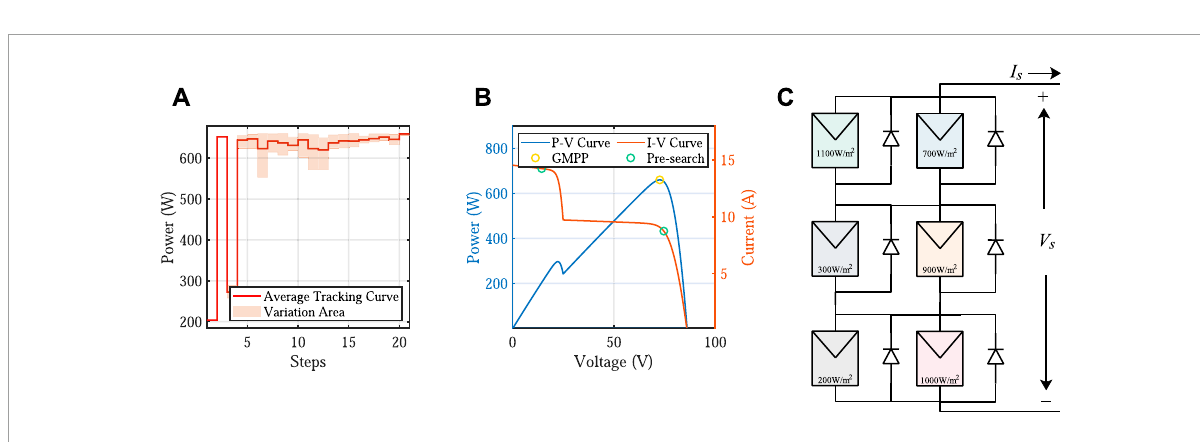
FIGURE 9 Average and best power curves under considered PSC test of a PV array with 3*2 PV modules connected in TCT topology: (A) Average tracking power curve and variation area; (B) P-V and I-V curve of the tested PSC; (C) The PV array topology.